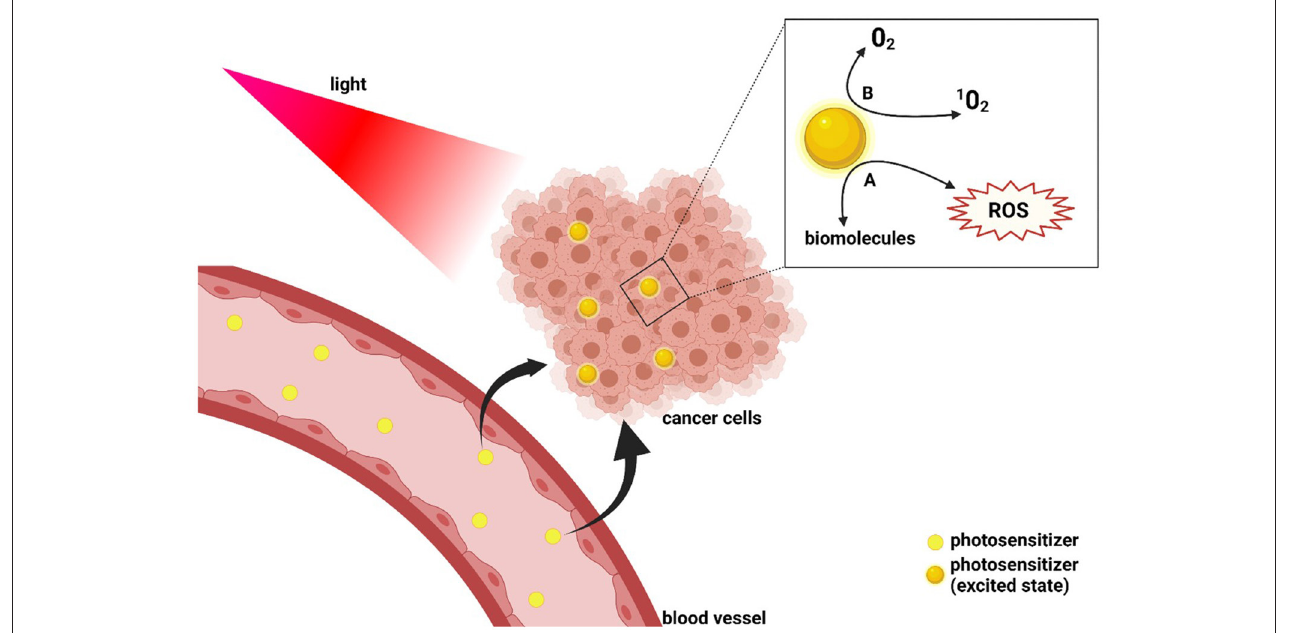
FIGURE 3 | Schematic representation of photodynamic therapy mechanism of function. After administration, the photosensitive agent is irradiated at a wavelength that matches its absorption properties. The excitation of the photosensitiser leads to two different types of reaction: the production of reactive oxygen species (ROS) as a result of the interaction of the photosensitiser with biomolecules (Reaction A) and the generation of singlet oxygen (Reaction